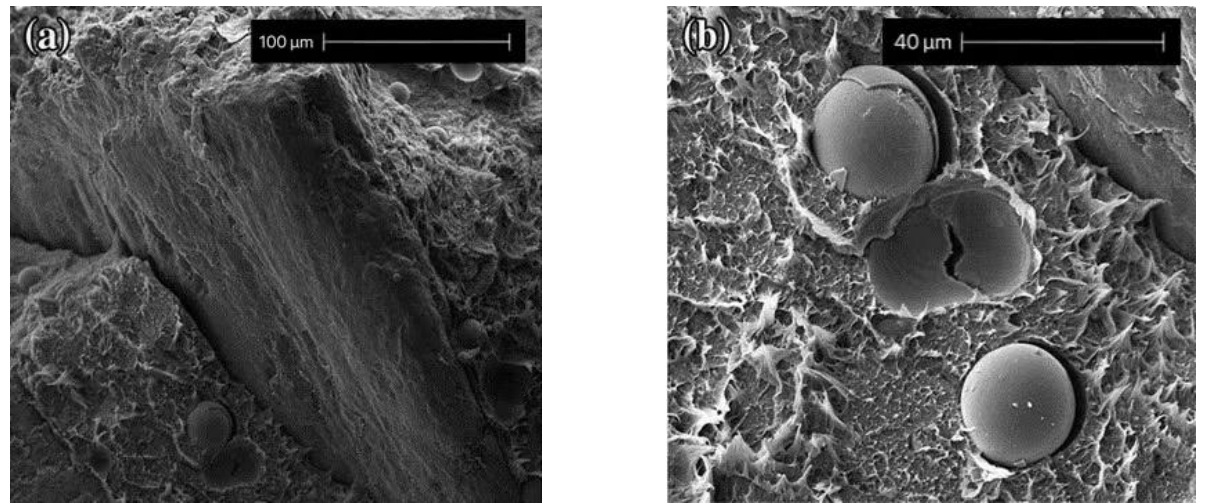
Figure 12. Interface diagram and partially enlarged figure of a composite without a coupling agent. ( a ) Mag = 460×; ( b ) Mag = 1415×. Adapted with permission [63], Copyright 2016, Springer.